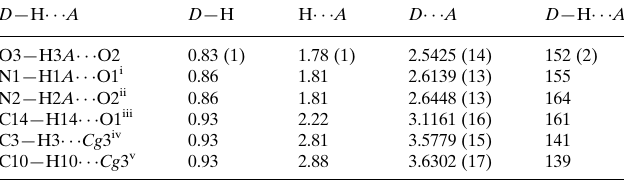
Hydrogen-bond geometry (A˚ , (cid:4) ). Cg 3 is the centroid of the C1–C6